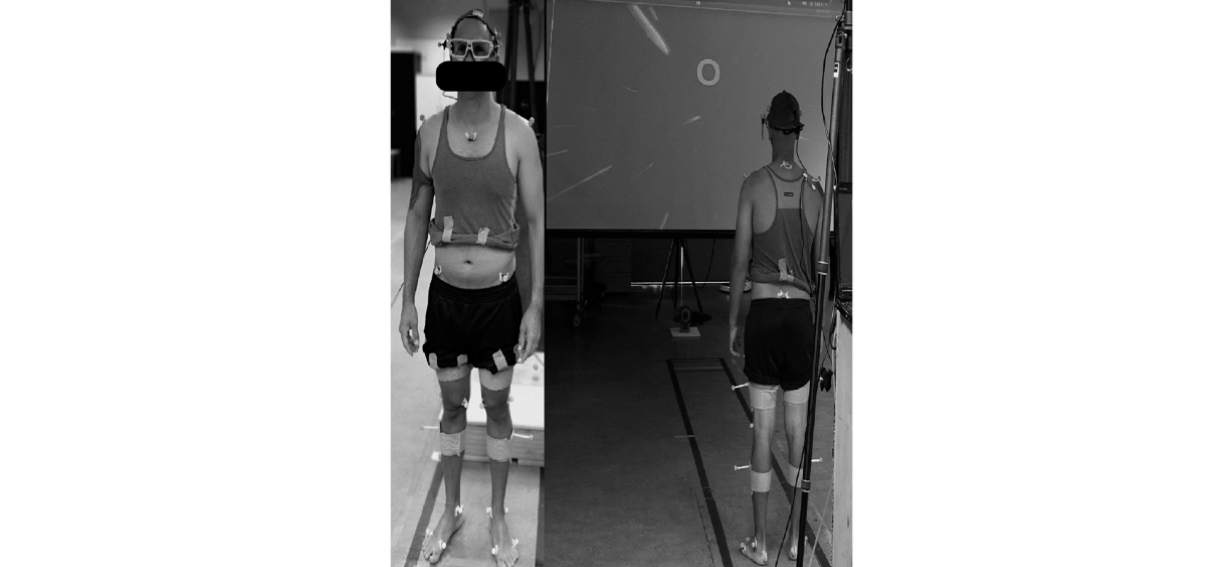
Figure 2. The experimental setup.